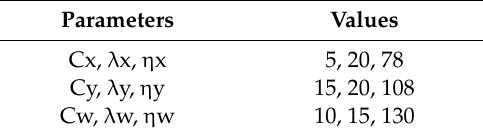
Table A1. DSMC design parameters.